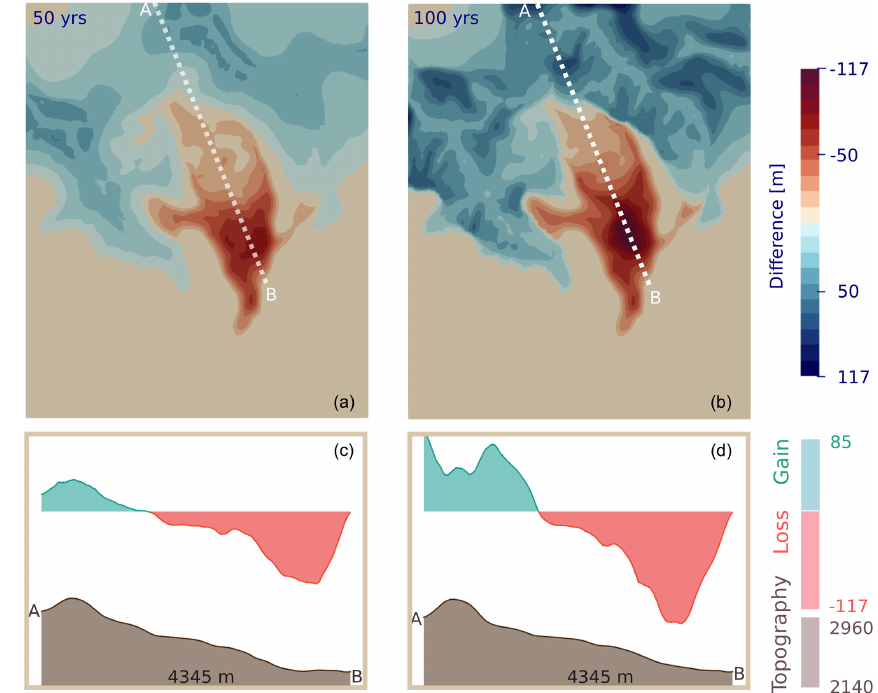
Figure 9. Elevation-dependent mass balance test. View of the difference between the initial surface elevation and simulation results at time steps (a) 50 and (b) 100 years and corresponding profiles with shaded surface topography in brown in (c) and (d)